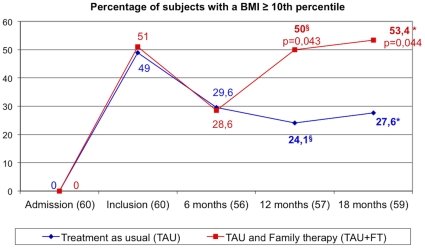
Percentages of participants with a BMI≥10th percentile.TAU: treatment as usual; TAU+FT: treatment as usual and family therapy.